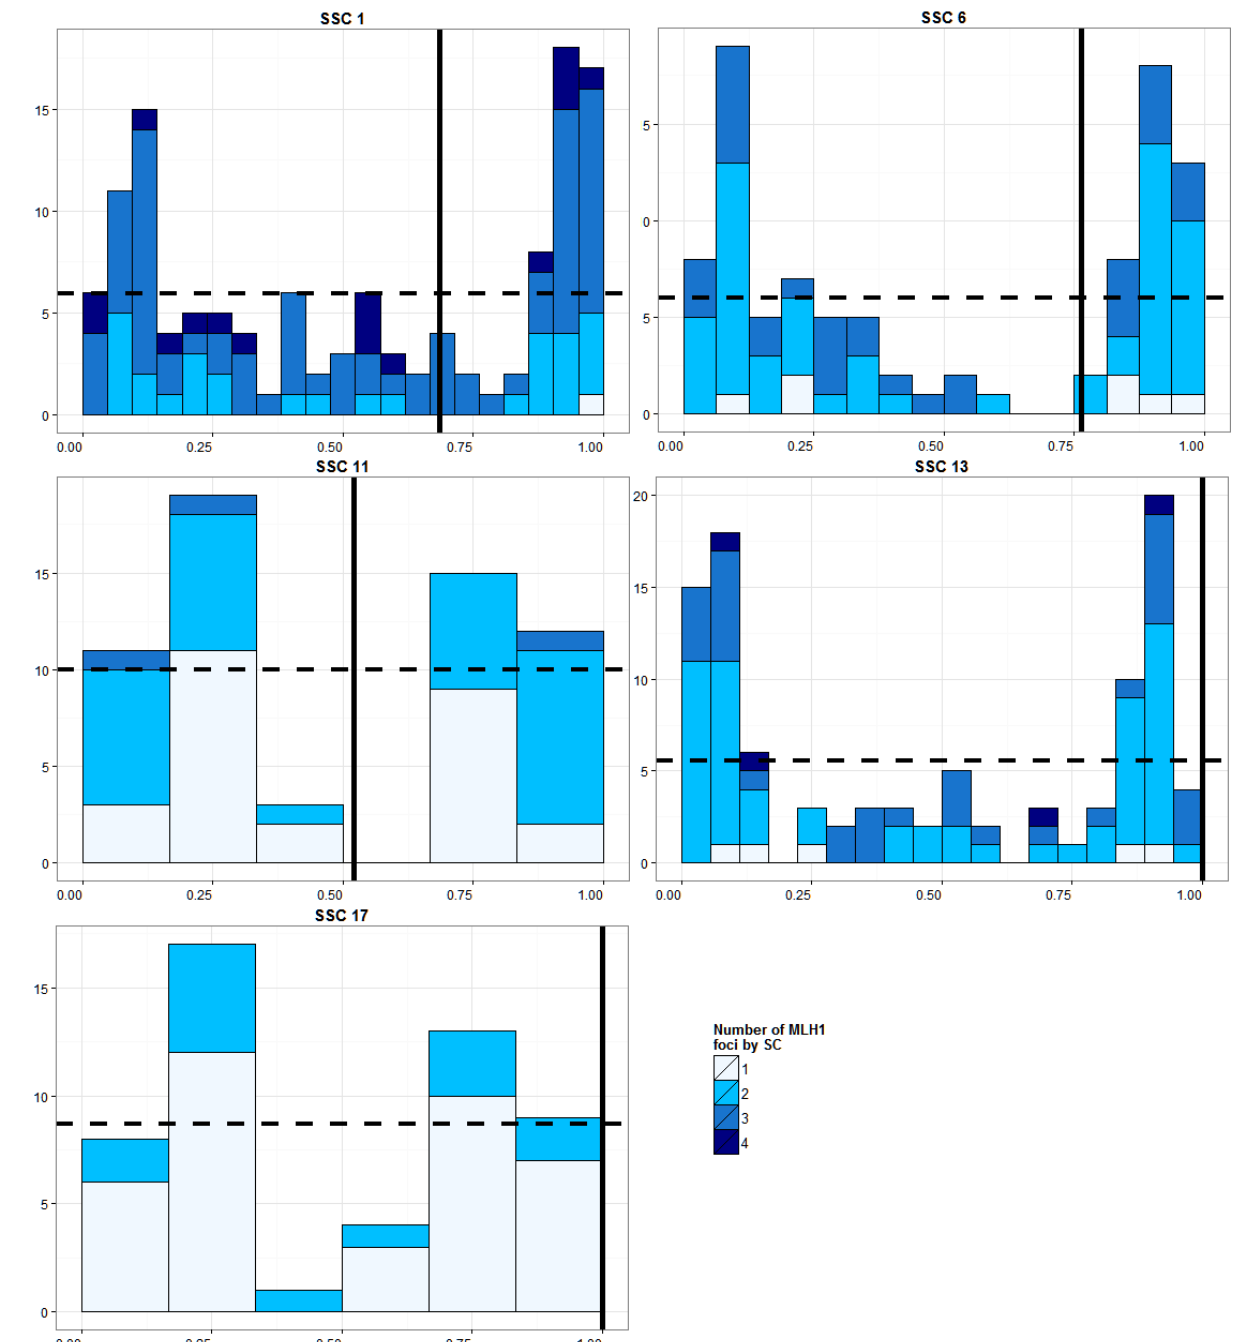
Figure 4. Distributions of MLH1 foci for 5 representative autosomes from LW 1.0. For each autosome, the x-axis indicates the position of the signals on the SC, from the q (left) arm to the p (right) arm. This axis is divided into a number of intervals proportional to the length of the SC. The y-axis indicates the number of MLH1 foci in each interval. The vertical line in bold represents the centromere and the dotted line the average number of MLH1 signals per SC. For each autosome, the columns (from lighter to darker blue) indicate bivalent with 1, 2, 3 or 4 MLH1 foci.